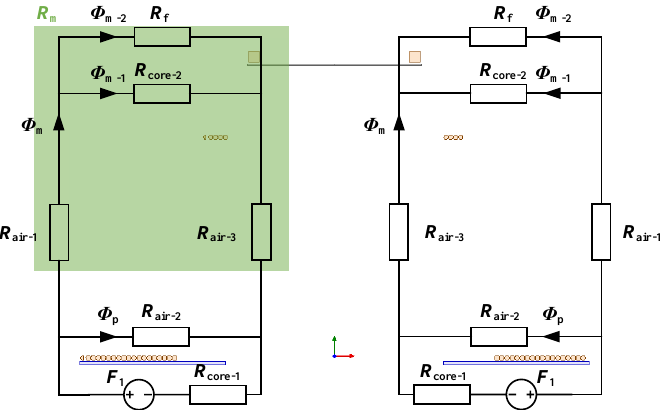
Figure 12. Equivalent model of carbon fiber fuselage.